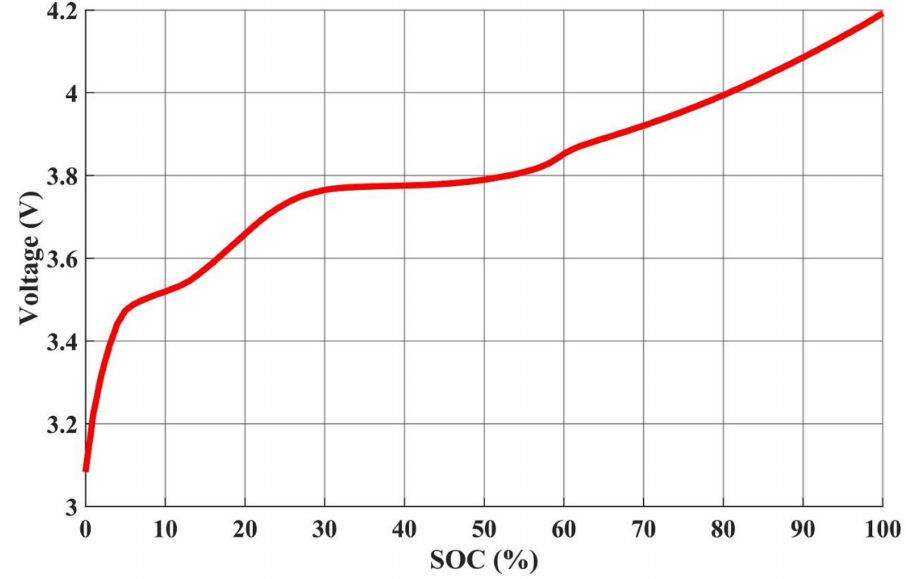
Figure 7. Relationship between open circuit voltage ( V ocv ) and state-of charge